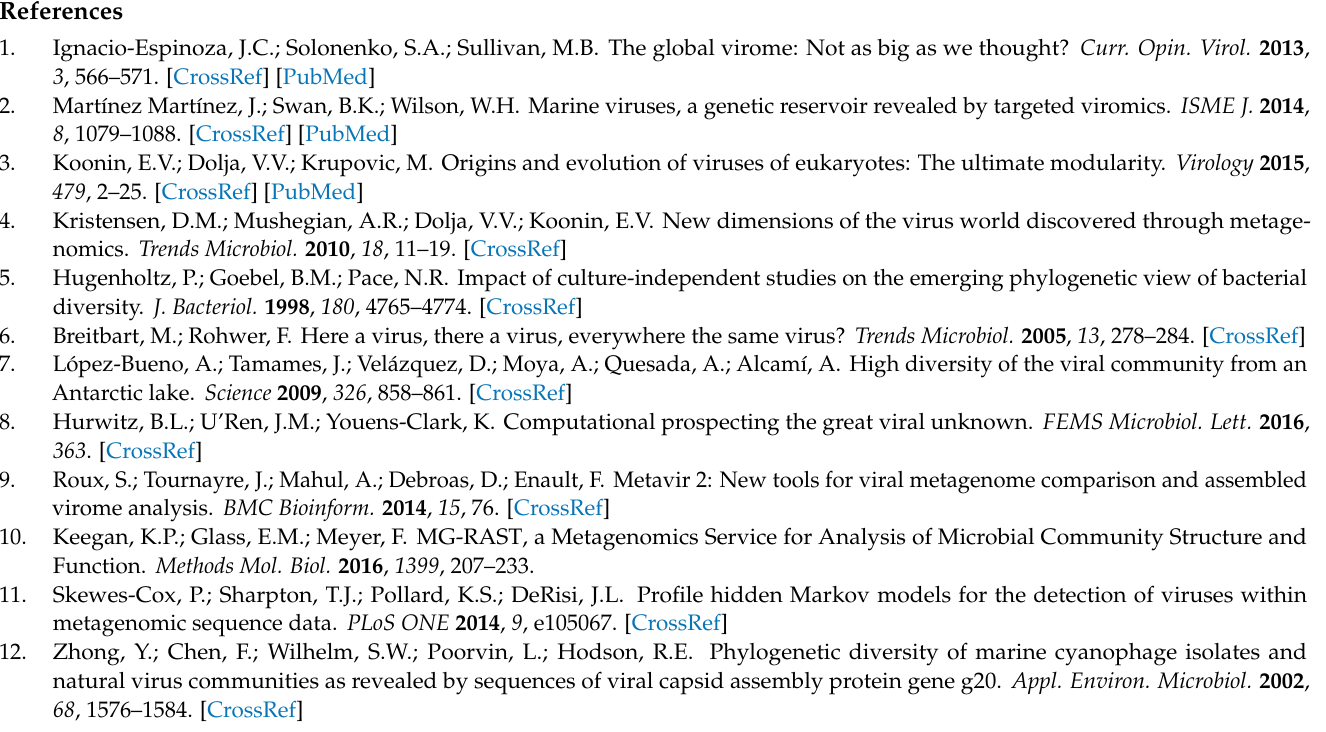
of the number of genomes available, Figure S6: Selection of the informative ViPhOGs, Table S1: Genomes summary, Table S2: Largest ViPhOGs, Table S3: Top 10 classifications errors per taxonomic level, and Table S4: Informative ViPhOGs